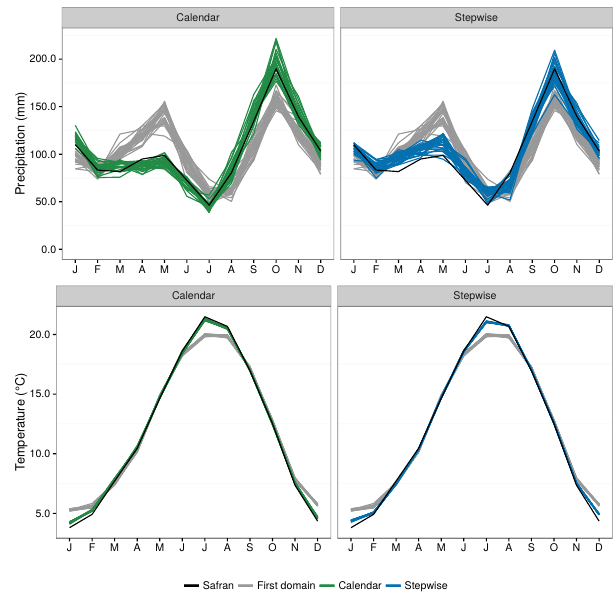
Figure 5. As for Fig. 4 but for the Cévennes case study